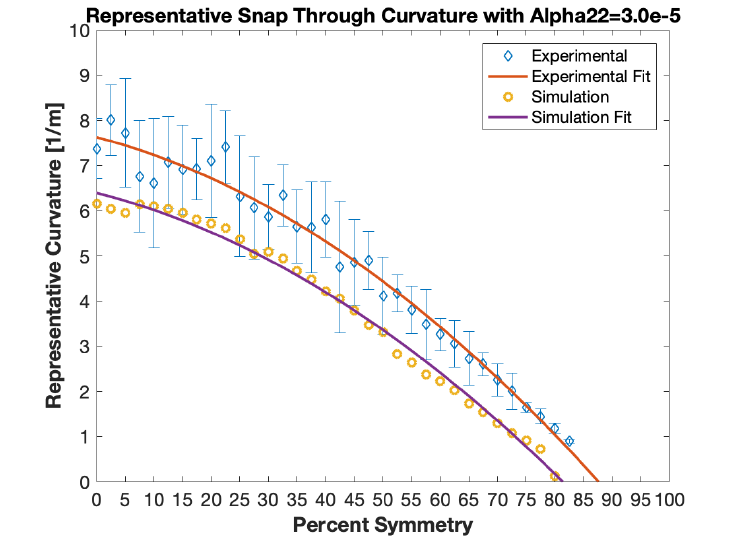
Figure 12. The snap through curvature versus the percent symmetry for all of the laminates simulated and studied that were bistable. Error bars on the experimental points show ± one standard